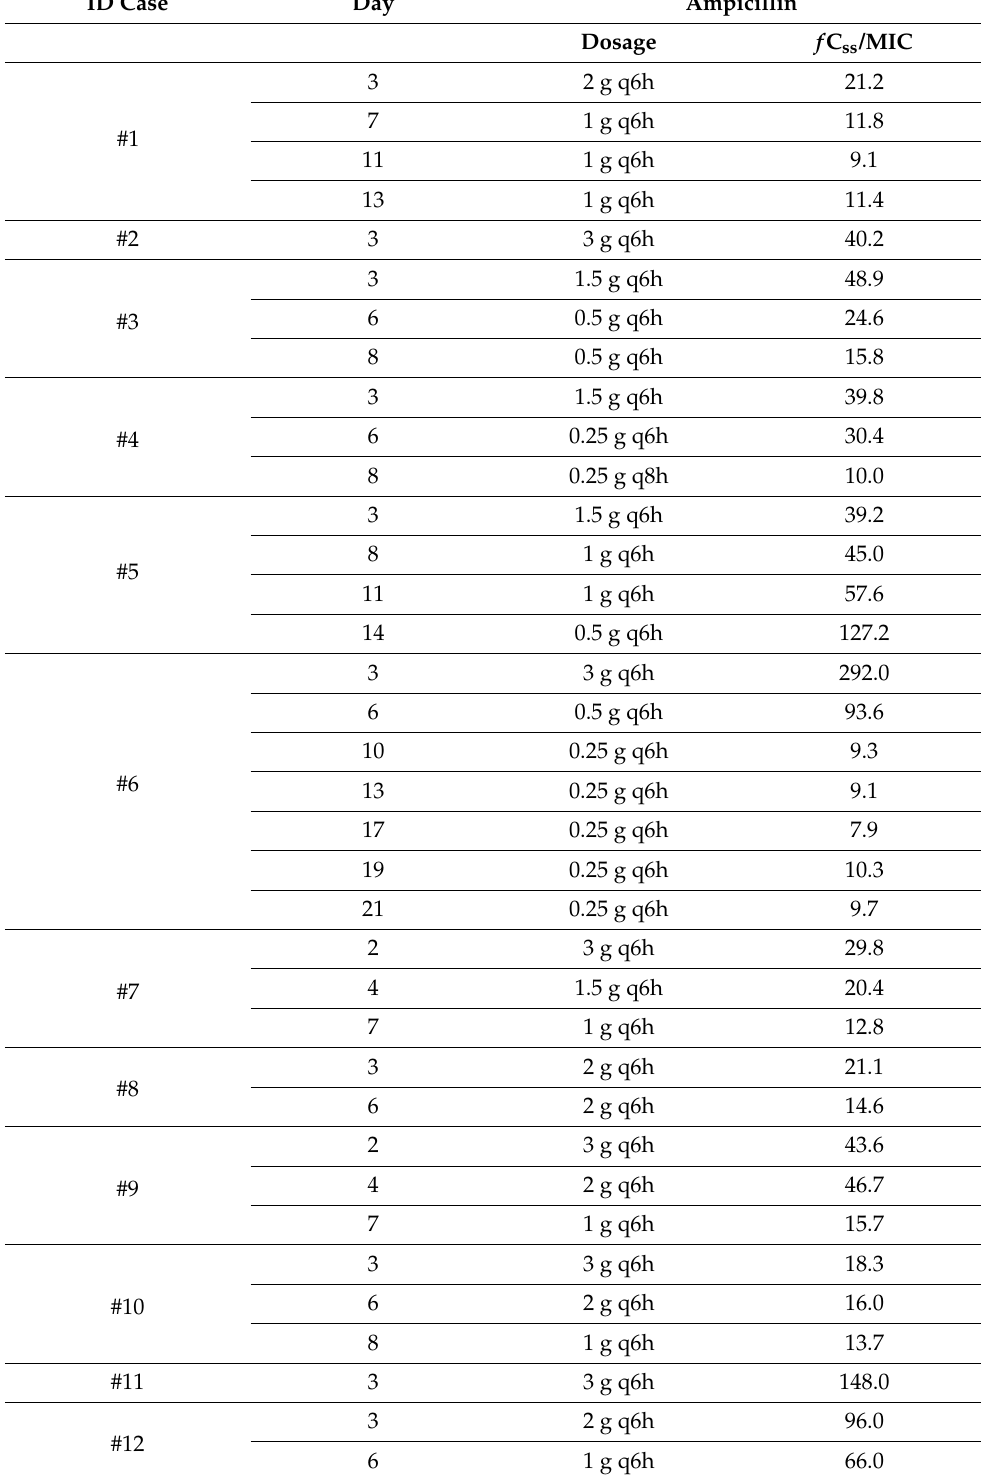
Table 2. Patients’ individual courses of the free ampicillin steady-state concentrations/MIC ratios and of the administered dosing